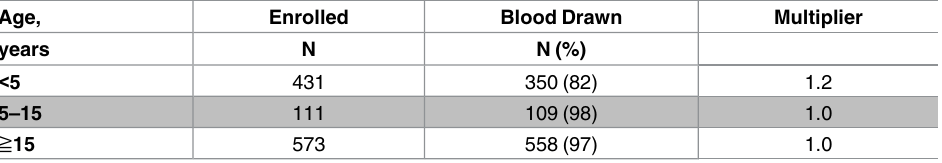
Table 4. Calculation of blood-draw multipliers, Moshi Rural and Moshi Urban Districts, Tanzania,